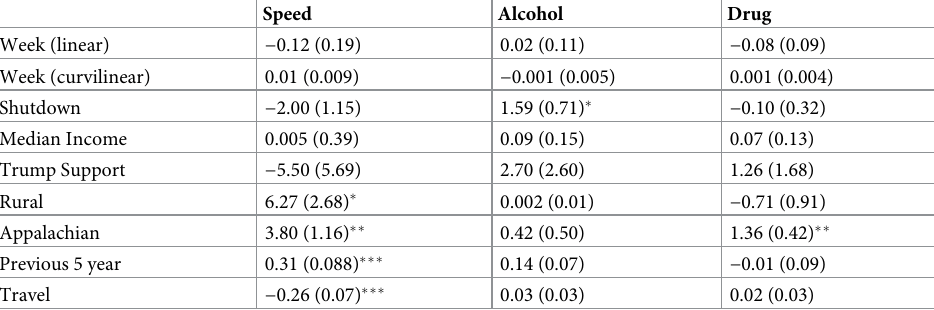
Parameter estimates (B) with standard errors in parentheses are reported.